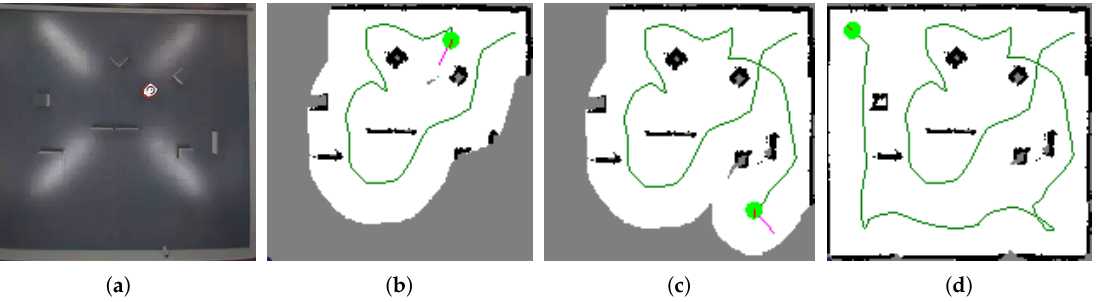
Figure 11. Experiment with a real robot in the SyRoTek system. ( a ) the robot during an experiment; ( b , c ) phases of the exploration process; ( d ) the final map and the performed